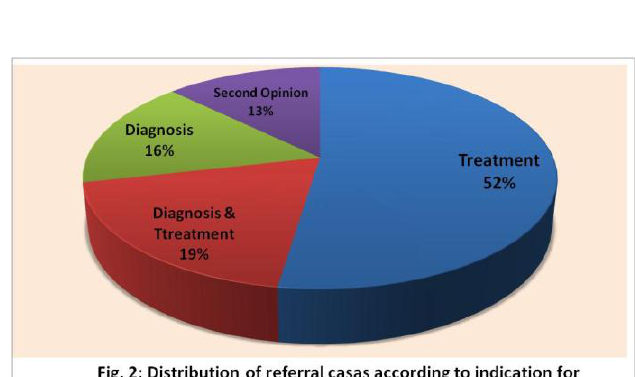
Table 3: Distribution of PHC doctors according to patient /month, and patient referred/month.